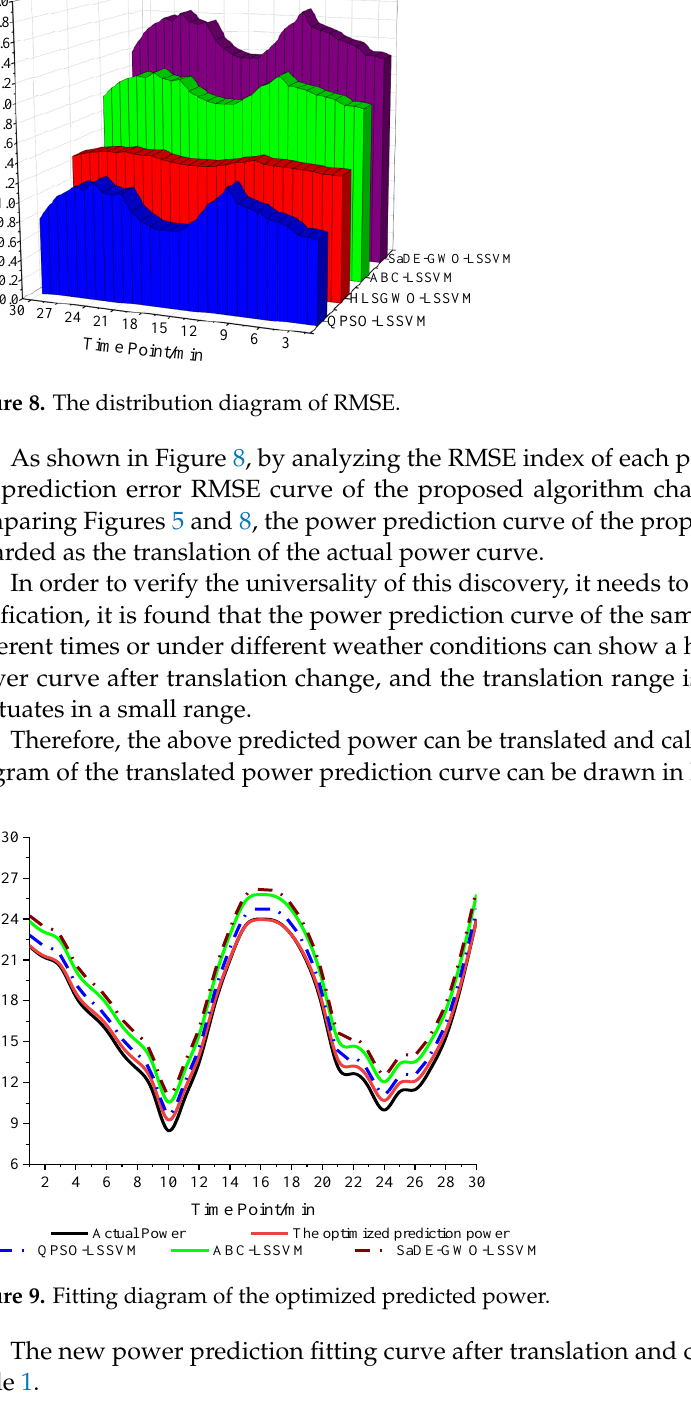
Algorithm type Figure 7. The resource occupancy of power prediction. As shown in Figure 7, the proposed algorithm can greatly reduce the resource occu- pancy rate for the power prediction calculation in the PV power generation system, and then relieve the pressure of computer calculation and improve the operating efficiency of the power generation systems.